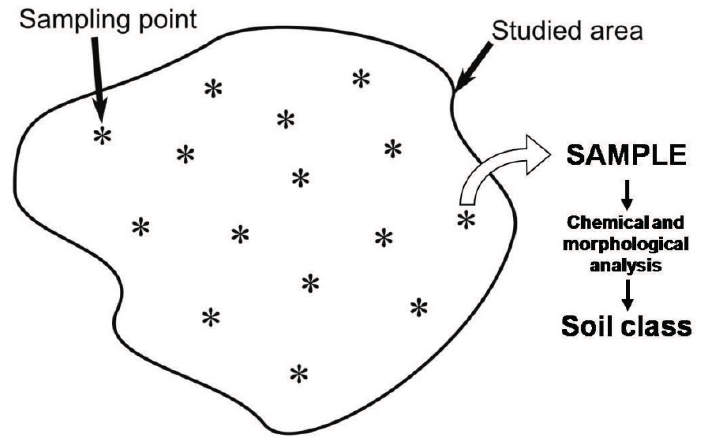
Figure 2. Example of random distribution of 15 sampling points over the studied area. From each sampling point, a soil sample is collected. The class of the collected soil samples is determined by means of chemical and morphological